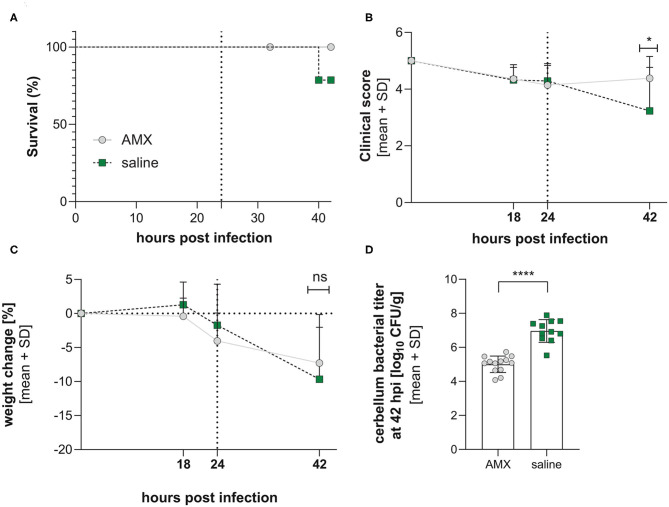
Clinical parameters in infection with a mixture of the 4 RMS allele variants. Comparison between AMX-treated and saline-treated animals didn't reveal changes in survival (A) (AMX = 14, control = 14). In contrast, clinical score (B), weight change (C), and bacterial titer in the cerebellum (D) were significantly improved by AMX treatment with amoxicillin improves outcome (AMX = 13, control = 11). Statistical significance was reached for clinical score and cerebellum titers. The vertical dotted line represents the initiation of the amoxicillin treatment. *p < 0.05; ****p < 0.0001; ns: not significant.